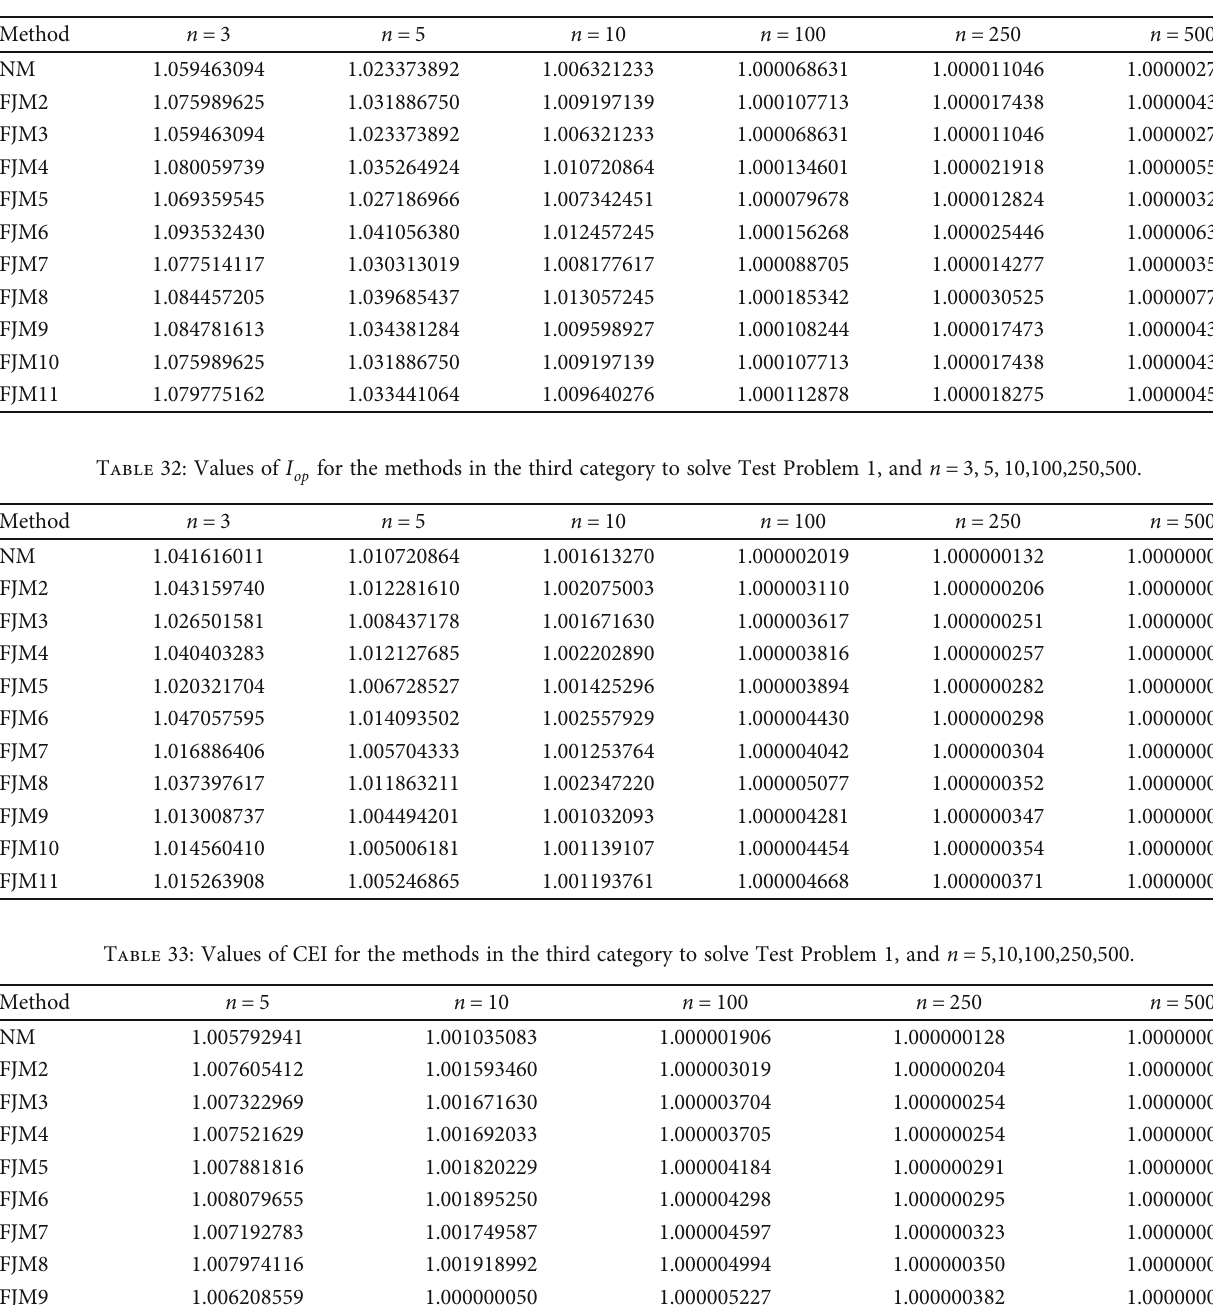
Table 31: Values of EI for the methods in the third category to solve Test Problem 1, and n = 3, 5, 10,100,250,500 . Method